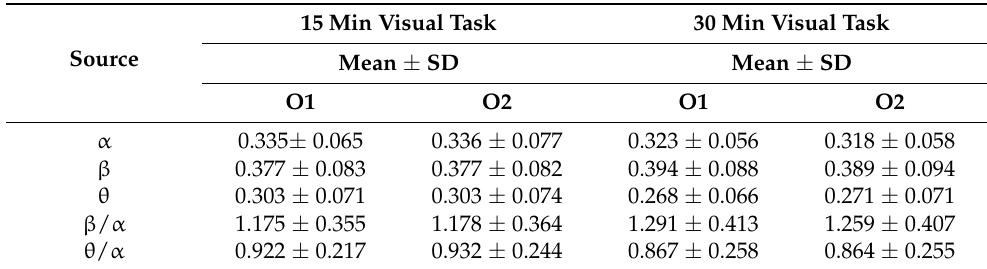
Table 3. Means and standard deviation results for the different EEG electrode locations. 15 Min Visual Source